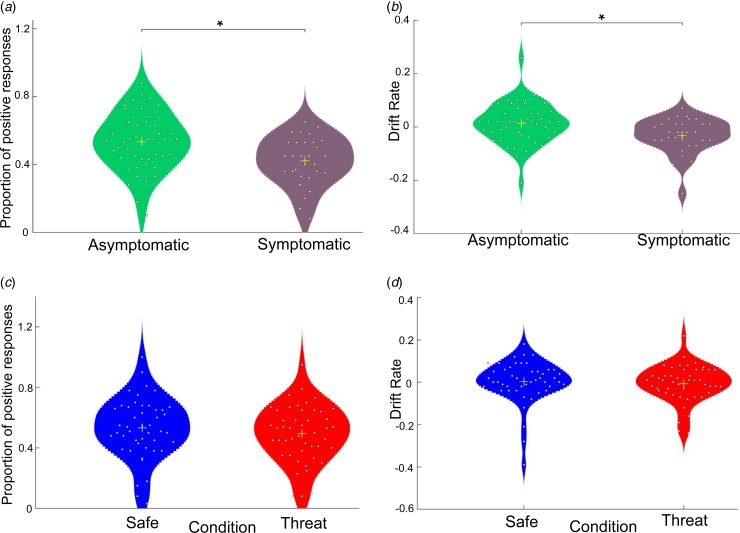
The impact of pathological and induced anxiety on ambiguous mid-tone predictions. Violin plots of the proportion of positive responses made to ambiguous tone and EZDM ‘drift rate’ – the rate of accumulation of evidence to classify a tone as high reward (shaded area represents a smoothed histogram; yellow cross represents the mean; each circle represents an individual). (a) Symptomatic individuals had more negative bias (p = 0.003, BF10 = 12.51) and (b) a more negative drift rate towards classifying the mid-tone as high reward (p = 0.008, BF10 = 5.22). However, there was (c) no significant difference in affective bias following induced anxiety (p = 0.06, BF10 = 0.863) and (d) no significant difference in drift rate across conditions (p > 0.125, BF10 < 1). EZDM, ‘easy’ diffusion model; BF, Bayes factor.